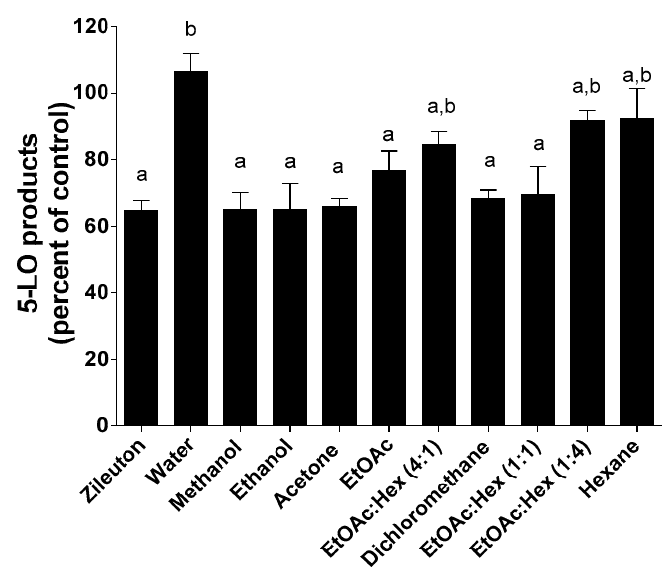
Figure 9. Inhibition of 5-LO product biosynthesis in HEK293 cells by zileuton (1 µM) and all dry extracts (5 µg/mL) following UAE. Values are the means ± SEM of at least three independent experiments, each performed in duplicate; values with different superscripts are significantly different ( p < 0.05) as determined by one-way ANOVA test with subsequent Tukey’s adjustment. Inhibition of 5-LO product biosynthesis is not directly related to the cytotoxicity against HEK293